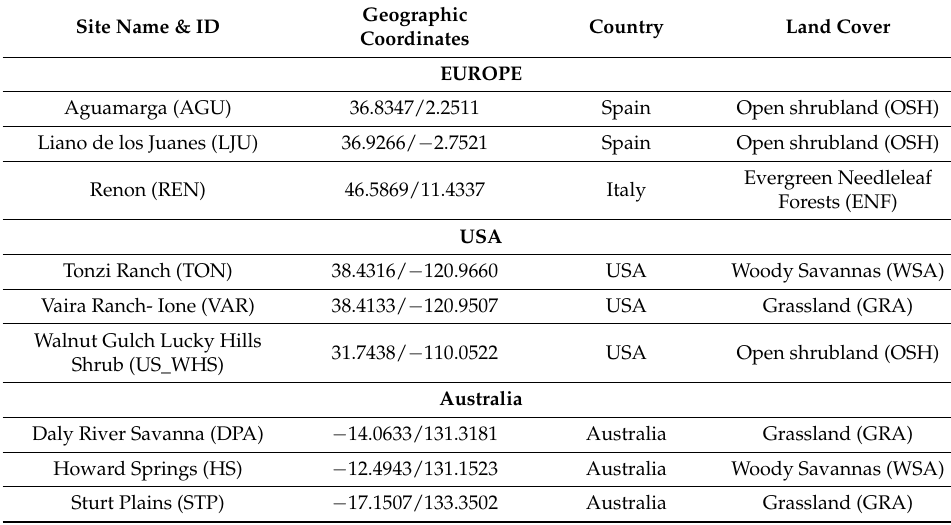
Table 1. Geographical location and land cover type for the FLUXNET flux tower sites that are used in our study by continent and